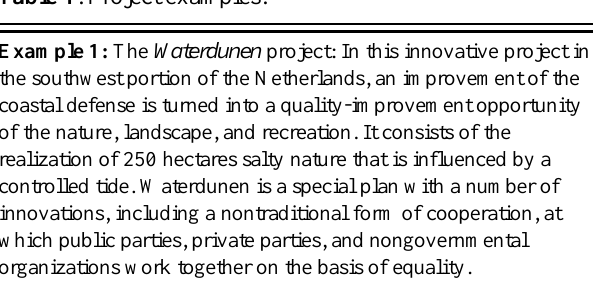
Table 1 . Project